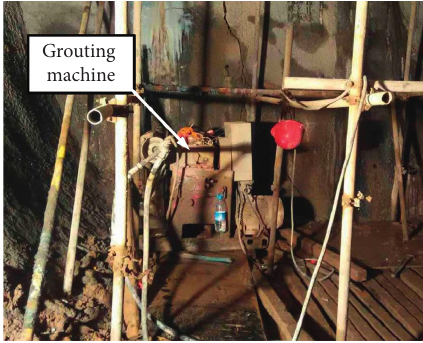
Figure 7: In situ grouting equipment and environment.